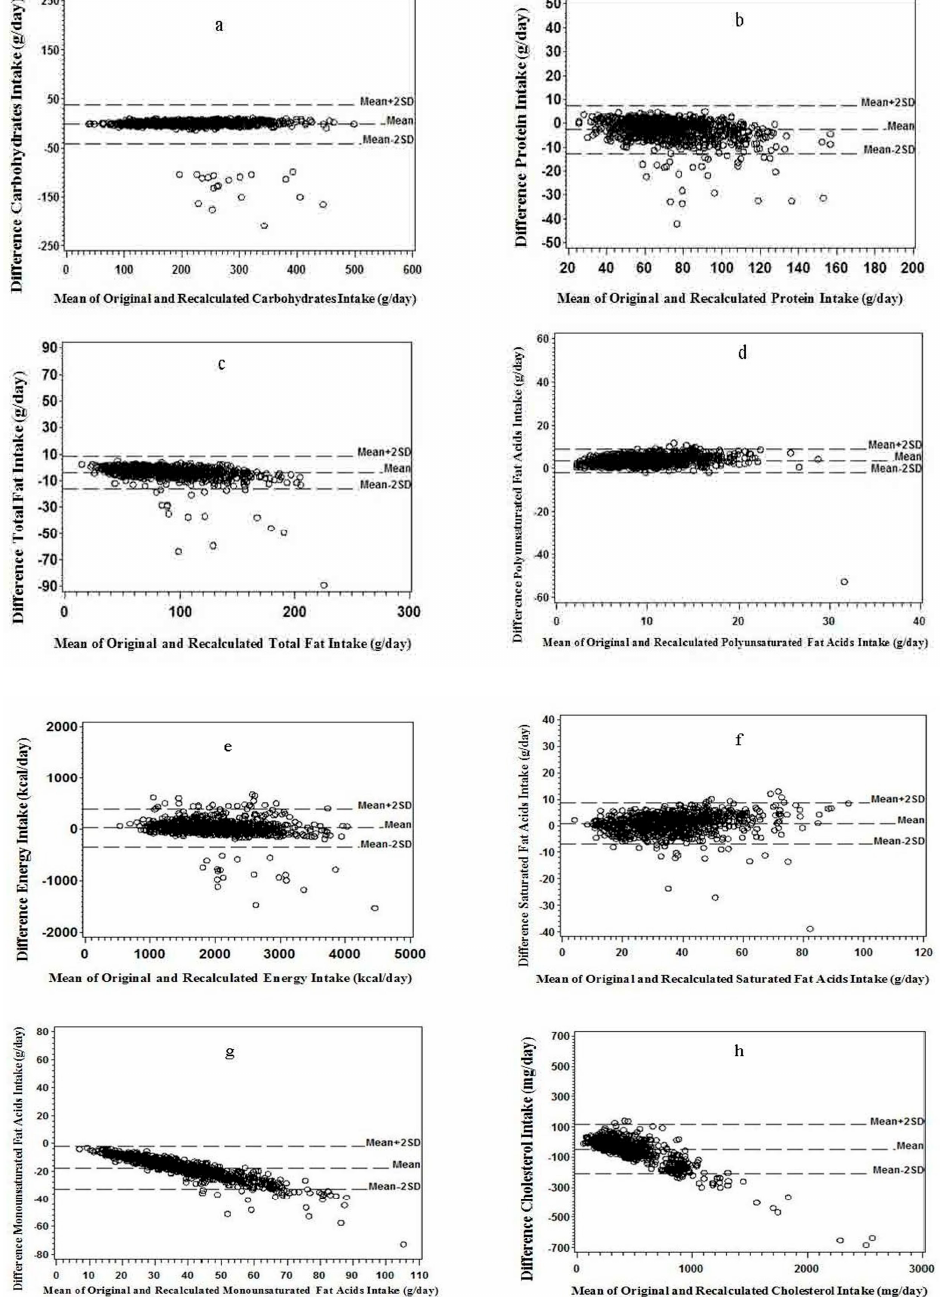
Figure 2. Bland–Altman plots for differences between versus mean of the recalculated and the original value for: ( a ) carbohydrate; ( b ) protein; ( c ) total fat; and ( d ) polyunsaturated fatty acids. Bland–Altman plots for differences between versus mean of the recalculated and the original value for: ( e ) energy; ( f ) saturated fatty acids; ( g ) monounsaturated fatty acids; and ( h ) cholesterol ( n = 910).